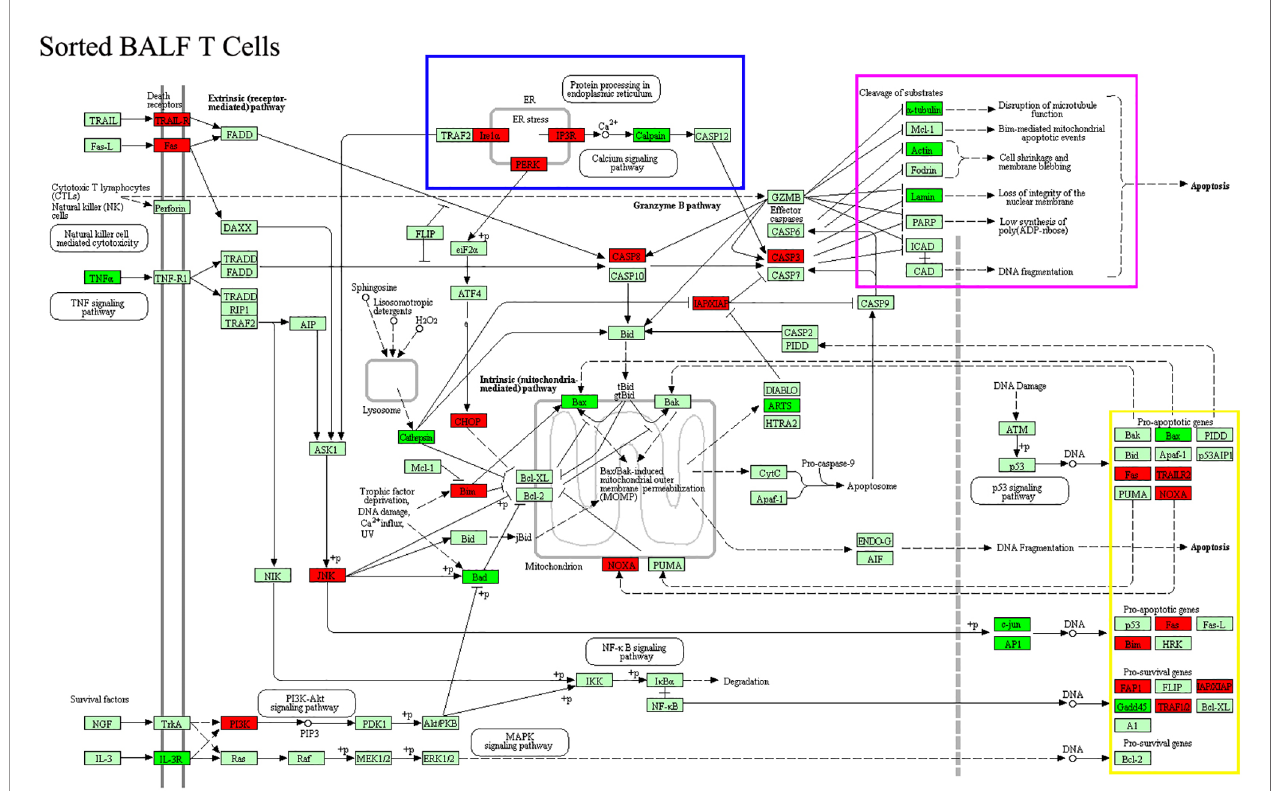
FIGURE 6 | DEGs of apoptotic genes in patient-sorted BALF T cells generated from the comparison with sorted BALF T cells in FB controls were processed with KEGG for apoptosis pathway analysis. Upregulated genes were labeled with red color, downregulated green. Cluster of DEGs with common function that is exclusive in patient-sorted T cells are boxed with different colors. DEGs of ER stress are boxed with blue. Substrates of cleavage, such as cell skeleton genes, are boxed with purple. Proapoptotic genes for DNA damaging are boxed with